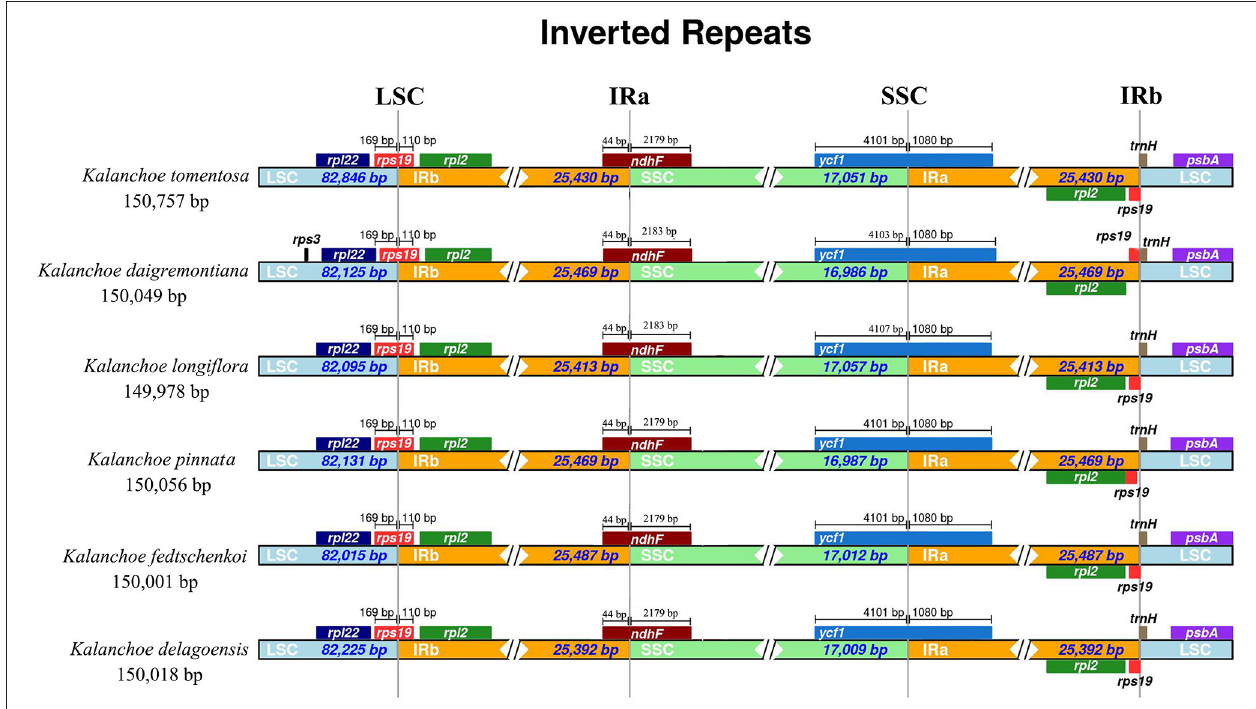
FIGURE 2 | Comparison of the border positions of large single copy (LSC), inverted repeat B (IRB), small single copy (SSC), and inverted repeat A (IRA) regions across the five Kalanchoe plastomes. Functional genes and truncated fragments are denoted by colored boxes. The sizes of gene fragments located at boundaries are indicated by the base pair